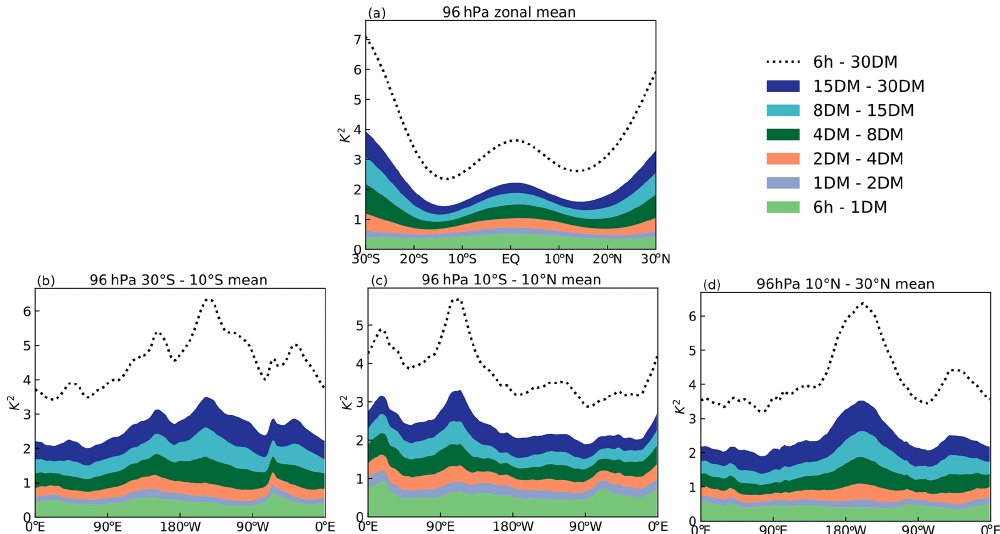
Figure 7. Mean square differences between time-filtered ERA-Interim temperatures. (a) Zonal mean 96hPa time series at each latitude and as a function of longitude between (b) 30–10 ◦ S, (c) 10 ◦ S–10 ◦ N, and (d) 10–30 ◦ N. Mean square difference between 6-hourly and 30d running mean (30DM) shown in dotted line, and sub-divisions of sub-monthly timescales (e.g. 1d running mean to 2d running mean, 1DM – 2DM) are